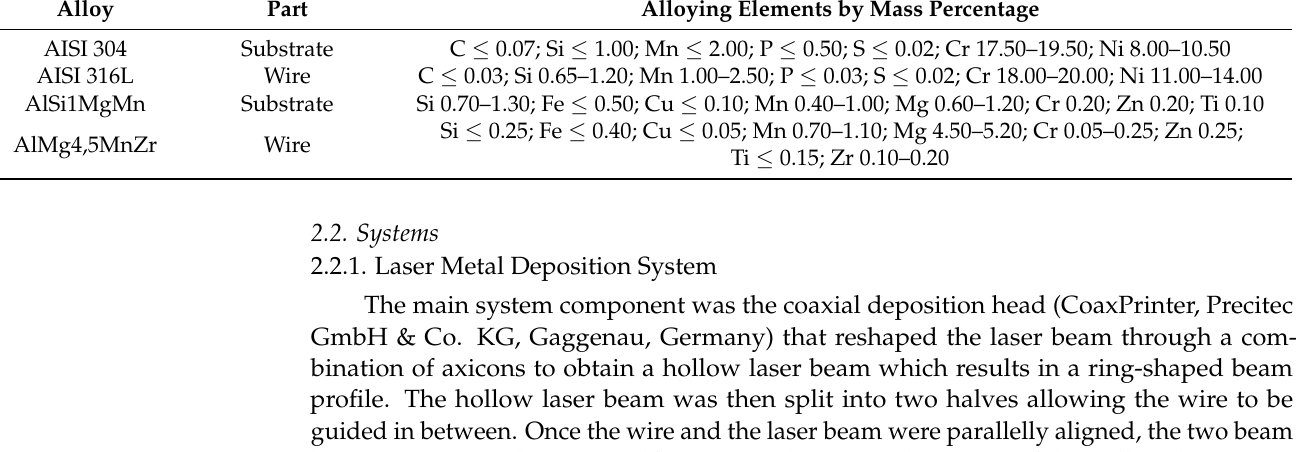
Table 1. Chemical composition of the materials used within the investigations. Alloy Alloying Elements by Mass